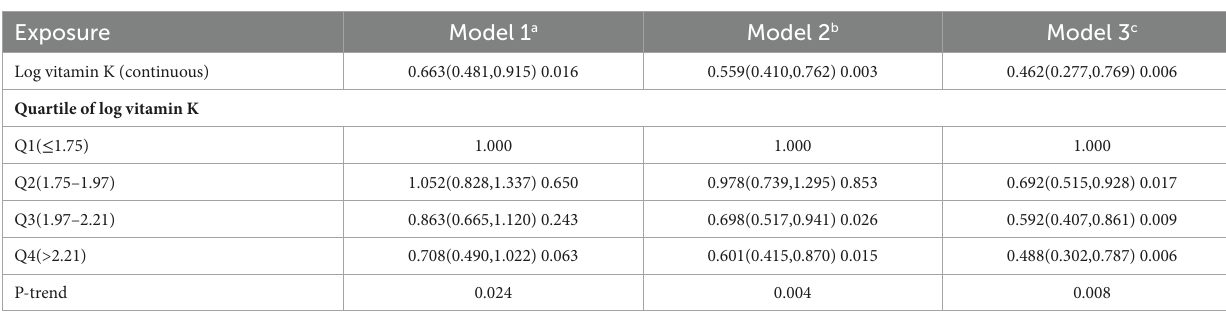
TABLE 2 The relationship of log vitamin K and MAFLD.